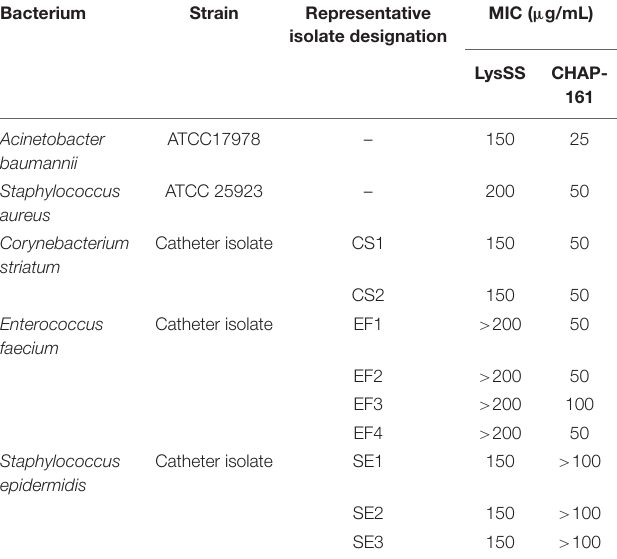
TABLE 2 | Minimum inhibitory concentrations (MICs) of LysSS and CHAP-161 against representative bacterial